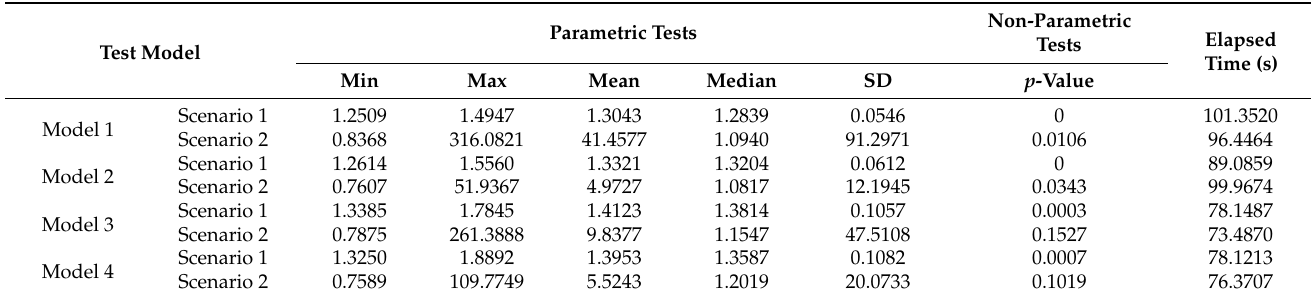
Table 13. Statistical measures of GTO performance in Agiba power network over 30 independent runs.